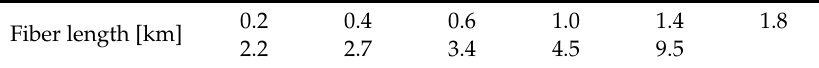
Table 1. Fiber lengths used in Brillouin spectrum